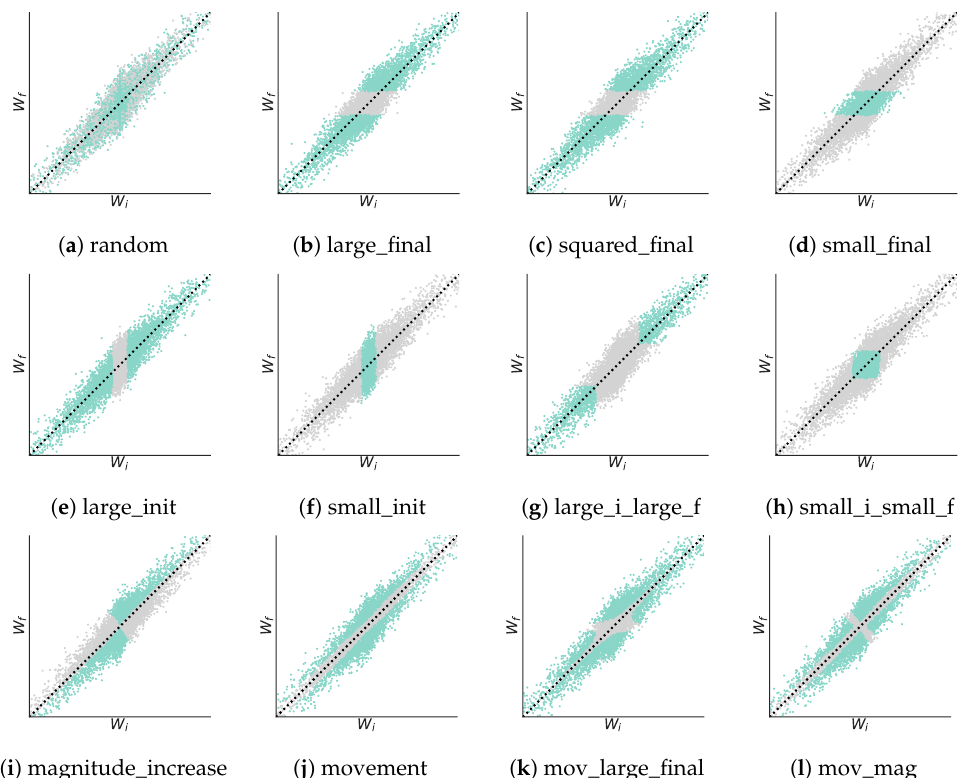
Figure 3. Common pruning selection criteria. A schematic weight distribution is represented, where colored weights are considered important by the criteria, while greyed out ones are